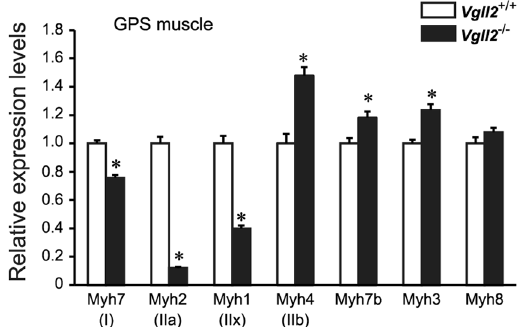
Figure 2. Expression analysis of myosin heavy chain isoforms in neonatal skeletal muscle. Expression levels of MyHC isoforms were measured by qPCR in the gastrocnemius-plantaris-soleus (GPS) muscle complex at postnatal day 7 (P7) of Vgll2 + / + and Vgll2 − / − mice (n = 8). Myh7 (encoding MyHCI), Myh2 (MyHCIIa), Myh1 (MyHCIIx), Myh4 (MyHCIIb), Myh7b (slow-tonic MyHC), Myh3 (embryonic fast isoform, MyHC-emb), and Myh8 (perinatal fast isoform, MyHC-pn) expression levels were examined. For comparison, the expression level of these genes in Vgll2 + / + mice was arbitrarily set at 1. Data are presented as mean ± SEM. * P < 0.05 vs. Vgll2 + / + muscles.